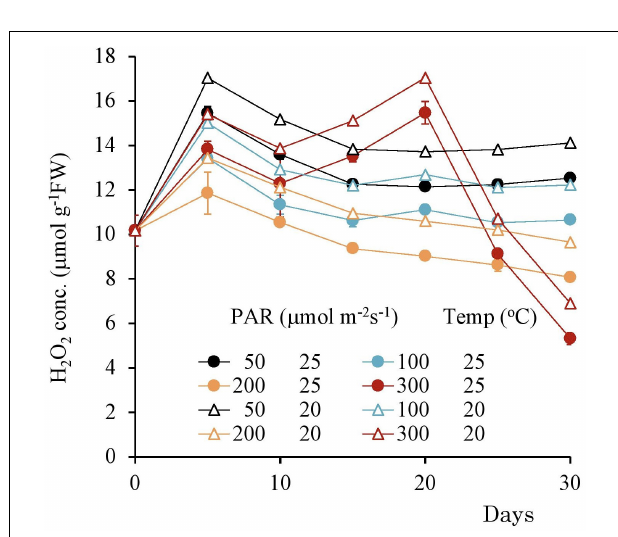
FIGURE 9 | The variational trend of the H 2 O 2 concentration of plant tissues after 7 days experiment with respect to different PAR. Vertical bars indicate the standard deviation.